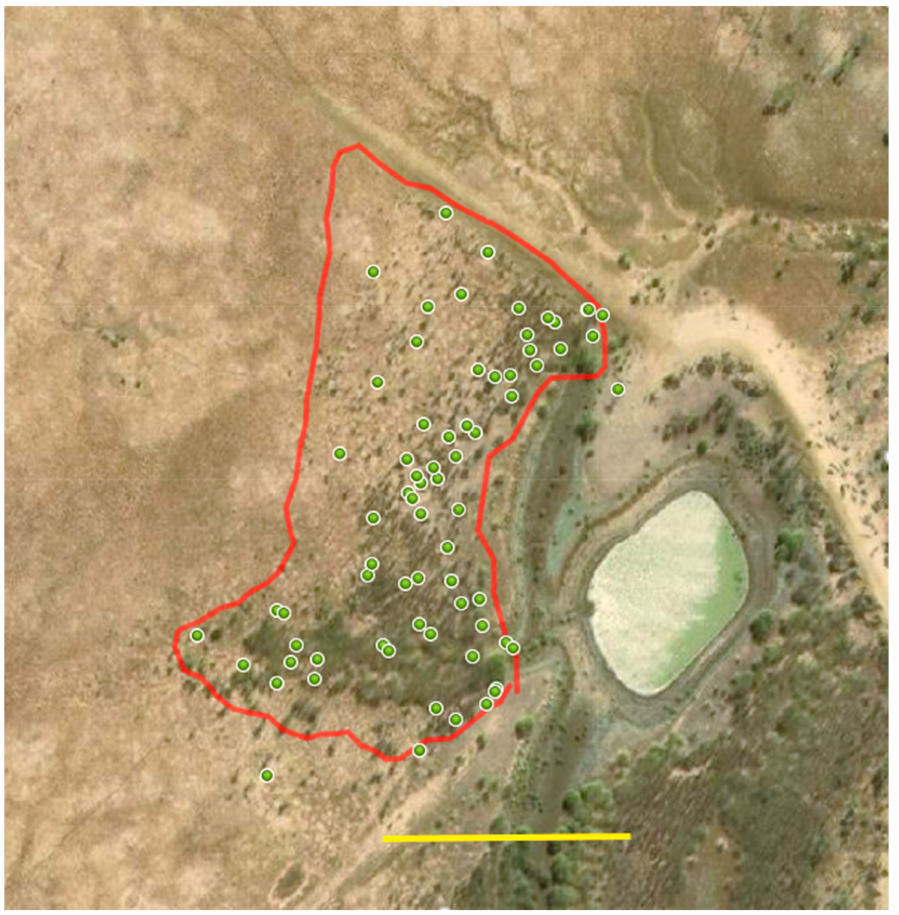
Figure 13. Outline (in red) of north infestation boundary as tracked by GPS surrounding the treatment area (1.9 ha); green markers indicating waypoints at which magazines of 15 doses were initiated. Scale bar = 100 m. Background imagery [24] accessed April